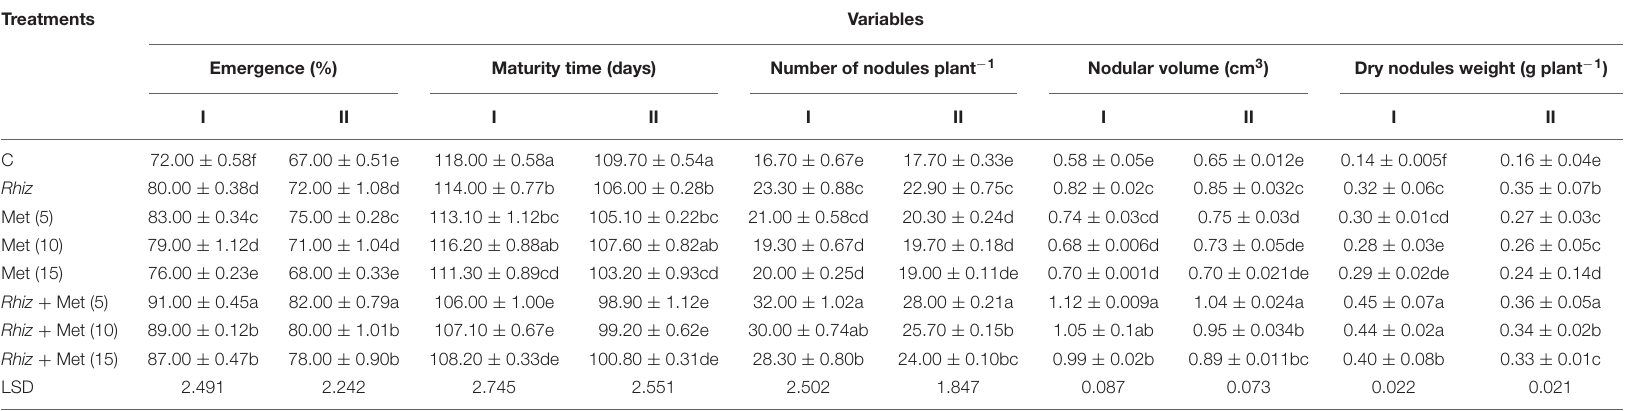
TABLE 5 | Chickpea growth and nodulation traits at different L-methionine levels and seed inoculation with Rhizobium .